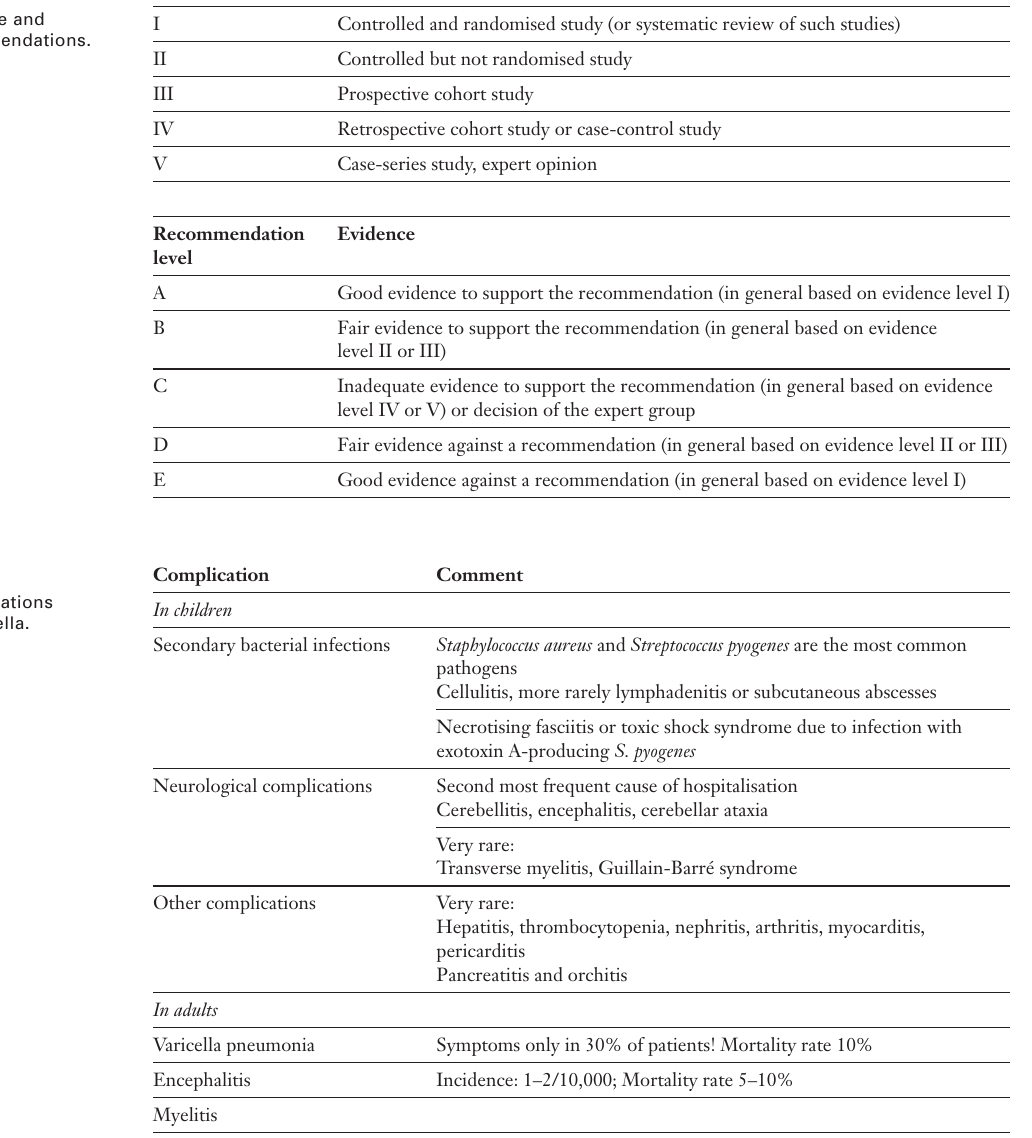
Evidence and recommendations.